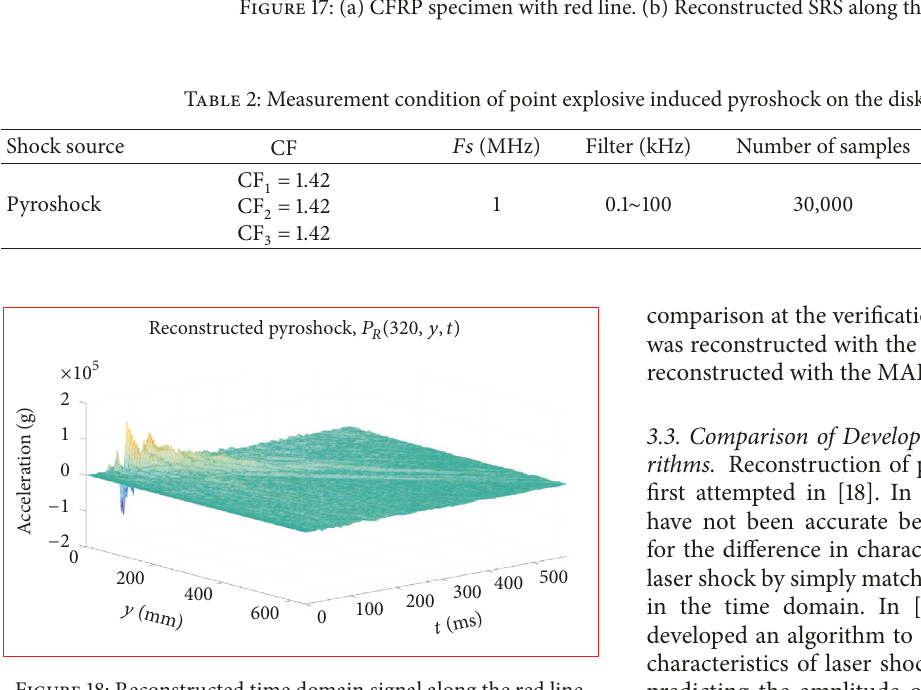
Figure 18: Reconstructed time domain signal along the red